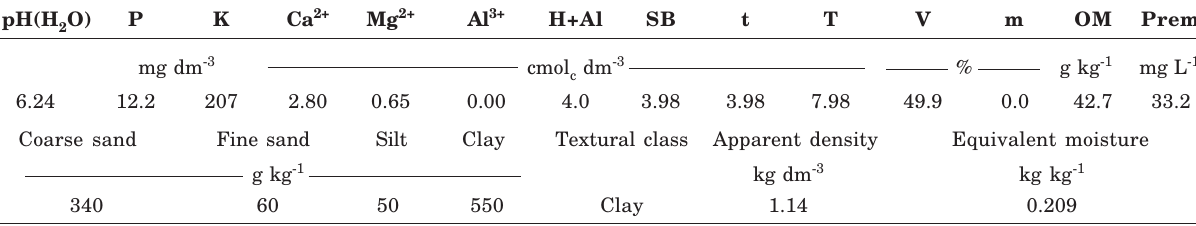
SB: sum of bases; t: effective cation exchange capacity (SB + Al 3+ ); T: cation exchange capacity at pH 7 (SB + H + Al); V: base saturation (100 SB/T); m: Al saturation (100 Al/t); OM: organic matter; P-rem: remaining phosphorus. (1) According to Embrapa